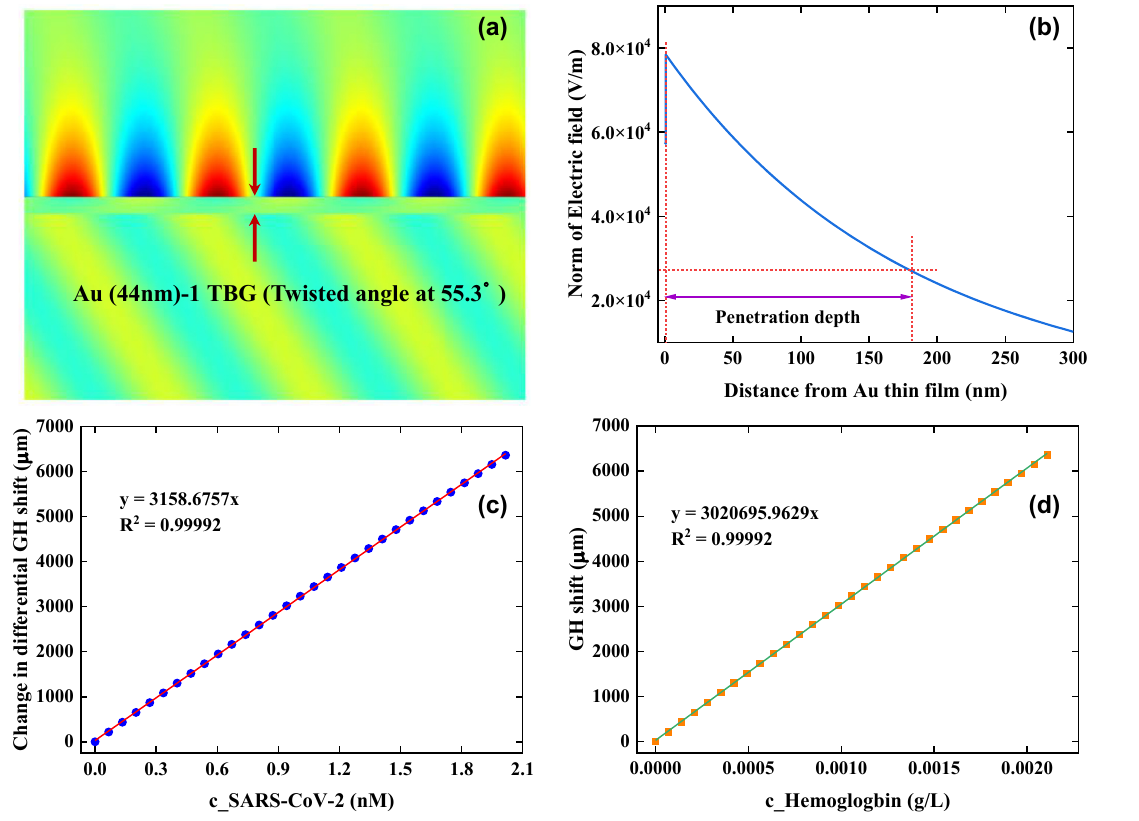
Figure 6: Highly enhanced evanescent field in 44 nm Au film-1 TBG hybrid configuration employed for quantitatively monitoring bioanalytes. (a) Generation of significantly enhanced evanescent field at the sensing interface of 44 nm Au film-1 TBG hybrid configuration. (b) Decay behavior of evanescent field propagating into running buffer. Excellent linear relationship between detection concentration of SARS-CoV-2 (c) and hemoglobin (d) and changes in differential GH shift in the configuration: 44 nm Au film-1-TBG with a twisted angle at 55.3 ◦ . Dotted curves in Figure 6(c) and (d) stand for demonstration from linear